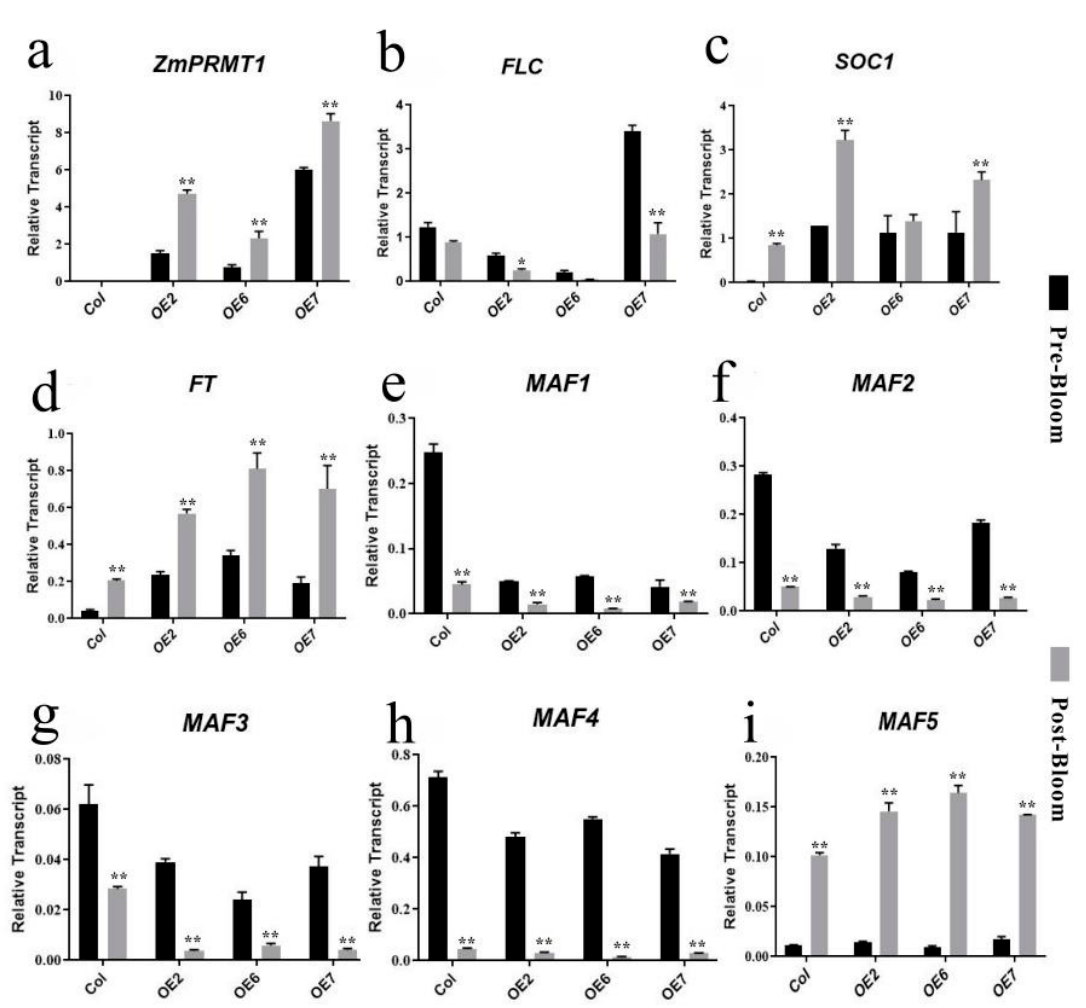
Figure 9. Expression of flowering-related genes by qRT-PCR analysis. The flowering-related genes, including ( b ) FLC (AT5G10140), MADS BOX PROTEIN FLOWERING LOCUS F; ( c ) SOC1 (AT2G45660), SUPPRESSOR OF OVEREXPRESSION OF CONSTANS 1; ( d ) FT (AT1G65480), FLOWERING LOCUS T; ( e ) MAF1 (AT1G77080), MADS AFFECTING FLOWERING 1; ( f ) MAF2 (AT5G65050) MADS AFFECTING FLOWERING 2; ( g ) MAF3 (AT5G65060) MADS AFFECTING FLOWERING 3; ( h ) MAF4 (AT5G65070) MADS AFFECTING FLOWERING 4; ( i ) MAF5 (AT5G65080) MADS AFFECTING FLOWERING 5. The mRNA levels were determined using qRT- PCR, and the values are reported relative to ZmPRMT1 mRNA levels in each line ( a ). The expression levels of related genes before flowering are represented by black columns, and the expression levels of related genes after flowering is represented by gray columns. Error bar is generated by three biological repetitions. The significance level is indicated by the asterisk at the top of the error bar. p < 0.05 is significantly different *; p < 0.01 is significantly different **.